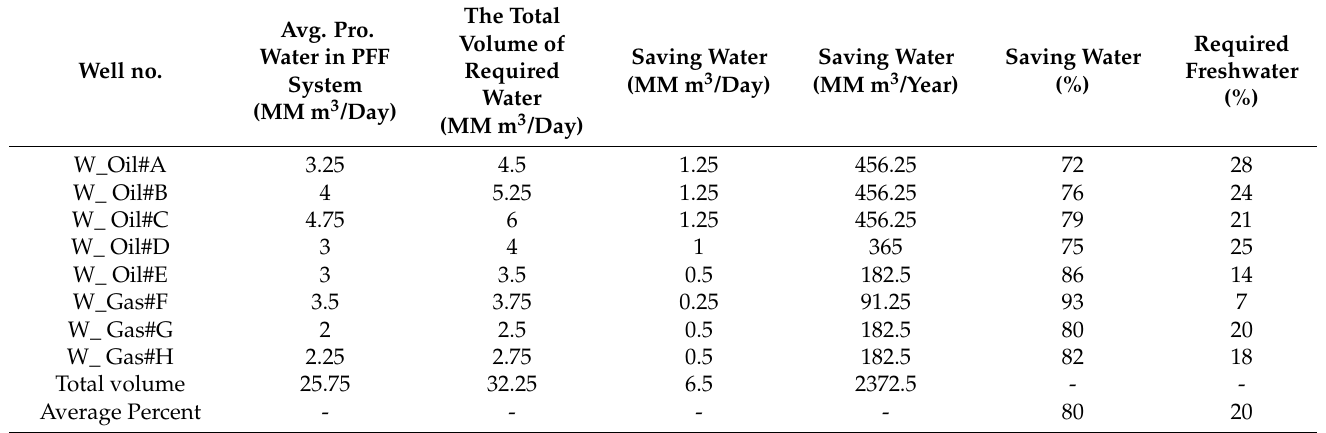
Table 1. A summary of water treatment savings for HF